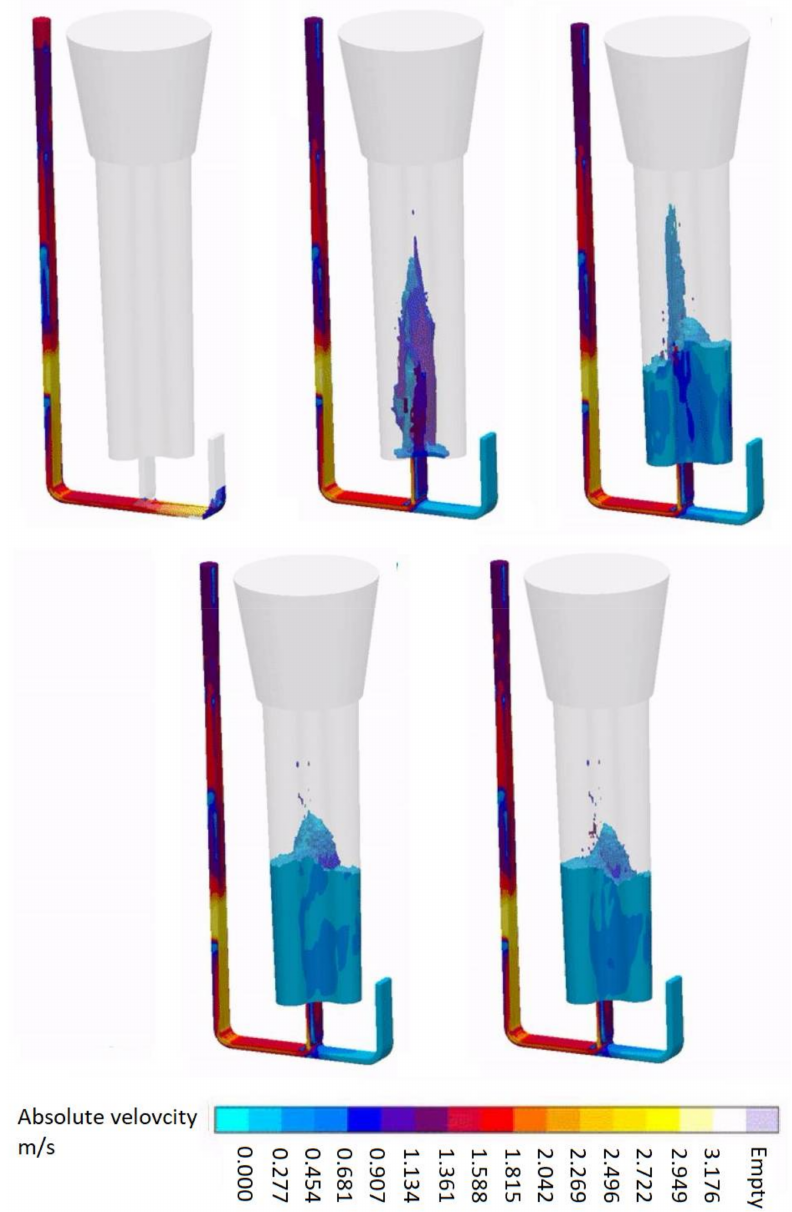
Figure 5. Prolonged runner system pouring process; filling time 10